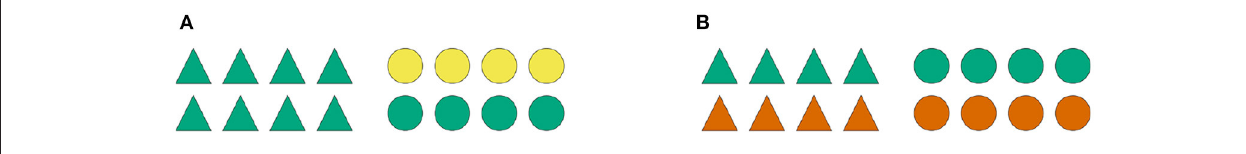
FIGURE 1 | Examples of visually presented context information which raises expectations of particular lexical material based on considerations of pragmatic felicity. Scene (A) should raise stronger expectations than scene (B) when the scalar quantifier some is used to describe the respective visual